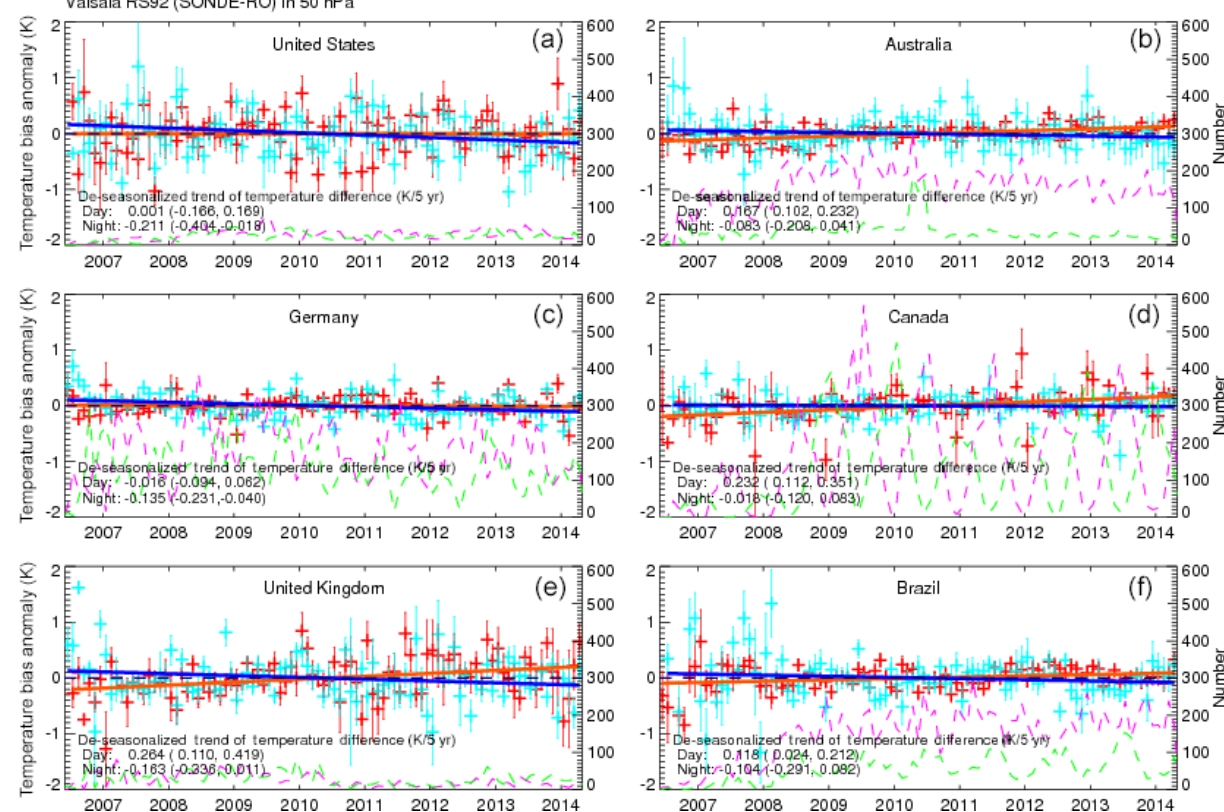
Figure 12. The time series of de-seasonalized temperature differences at 50hPa for RS92 for (a) United States, (b) Australia, (c) Germany, (d) Canada, (e) United Kingdom, and (f) Brazil. The red cross is the mean difference for RS92 minus RO temperature at 50hPa during the daytime and the blue cross is for that during the nighttime; the vertical lines superimposed on the mean values are the standard error of the mean for daytime and nighttime. The number of the monthly RAOB–RO pairs for daytime is indicated by the pink dashed line and that for nighttime by the green dashed line. The vertical lines superimposed on the monthly mean are the standard errors of the mean. Day and night trends are shown by solid red and blue lines, respectively. The zero difference is indicated by the dashed black line. The 95% confidence intervals for slopes are shown in the parentheses. The right y axis shows the sample number. The same symbols are also used in Fig. 13.